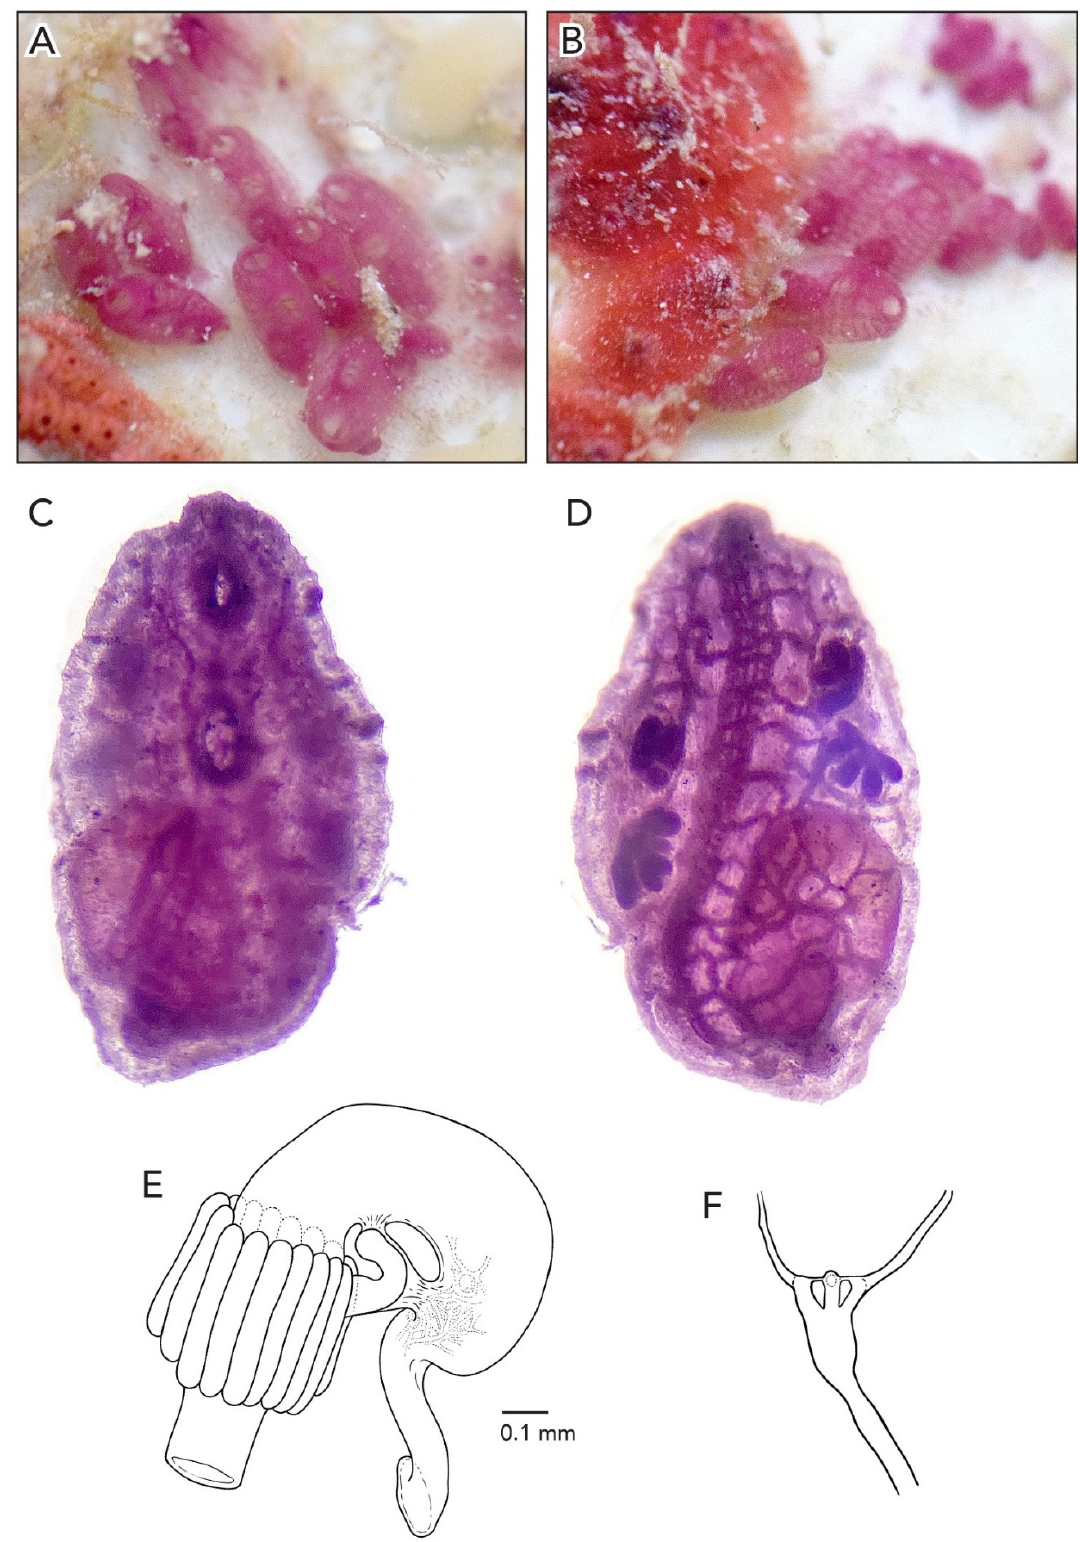
Figure 15. Symplegma sisalensis sp. nov. ( A , B ) Live colonies on the artificial substrate (PVC) ( C ) Dorsal view of preserved zooid ( D ) Ventral view of a preserved zooid ( E ) Peritubercular area ( F ) Detail of the abdomen region.